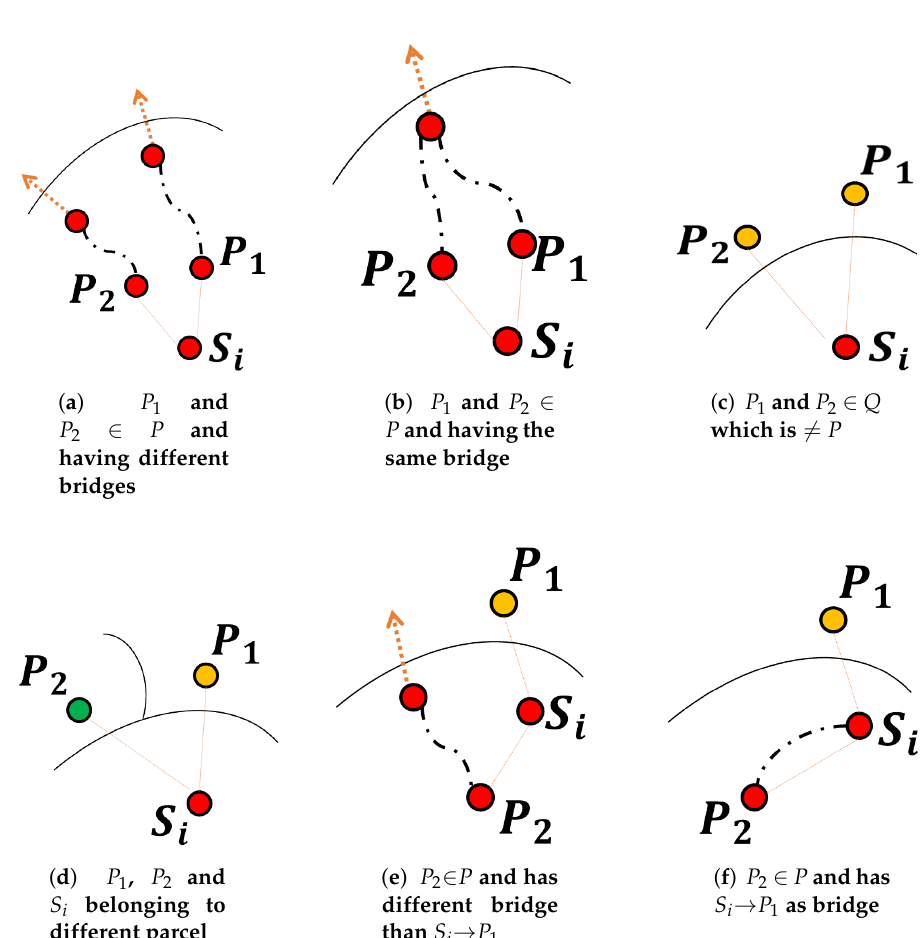
Figure 5. Examples of parent selection